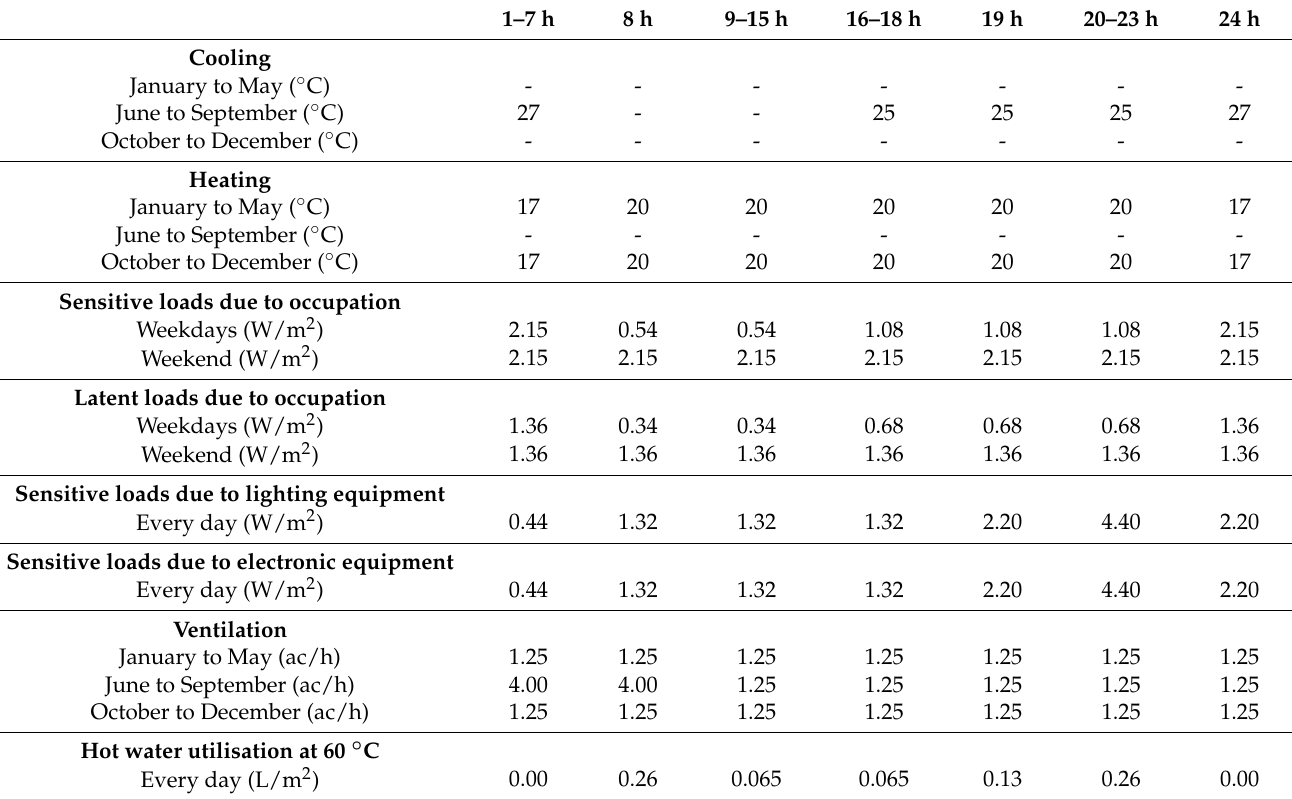
Table 3. Energetic simulation